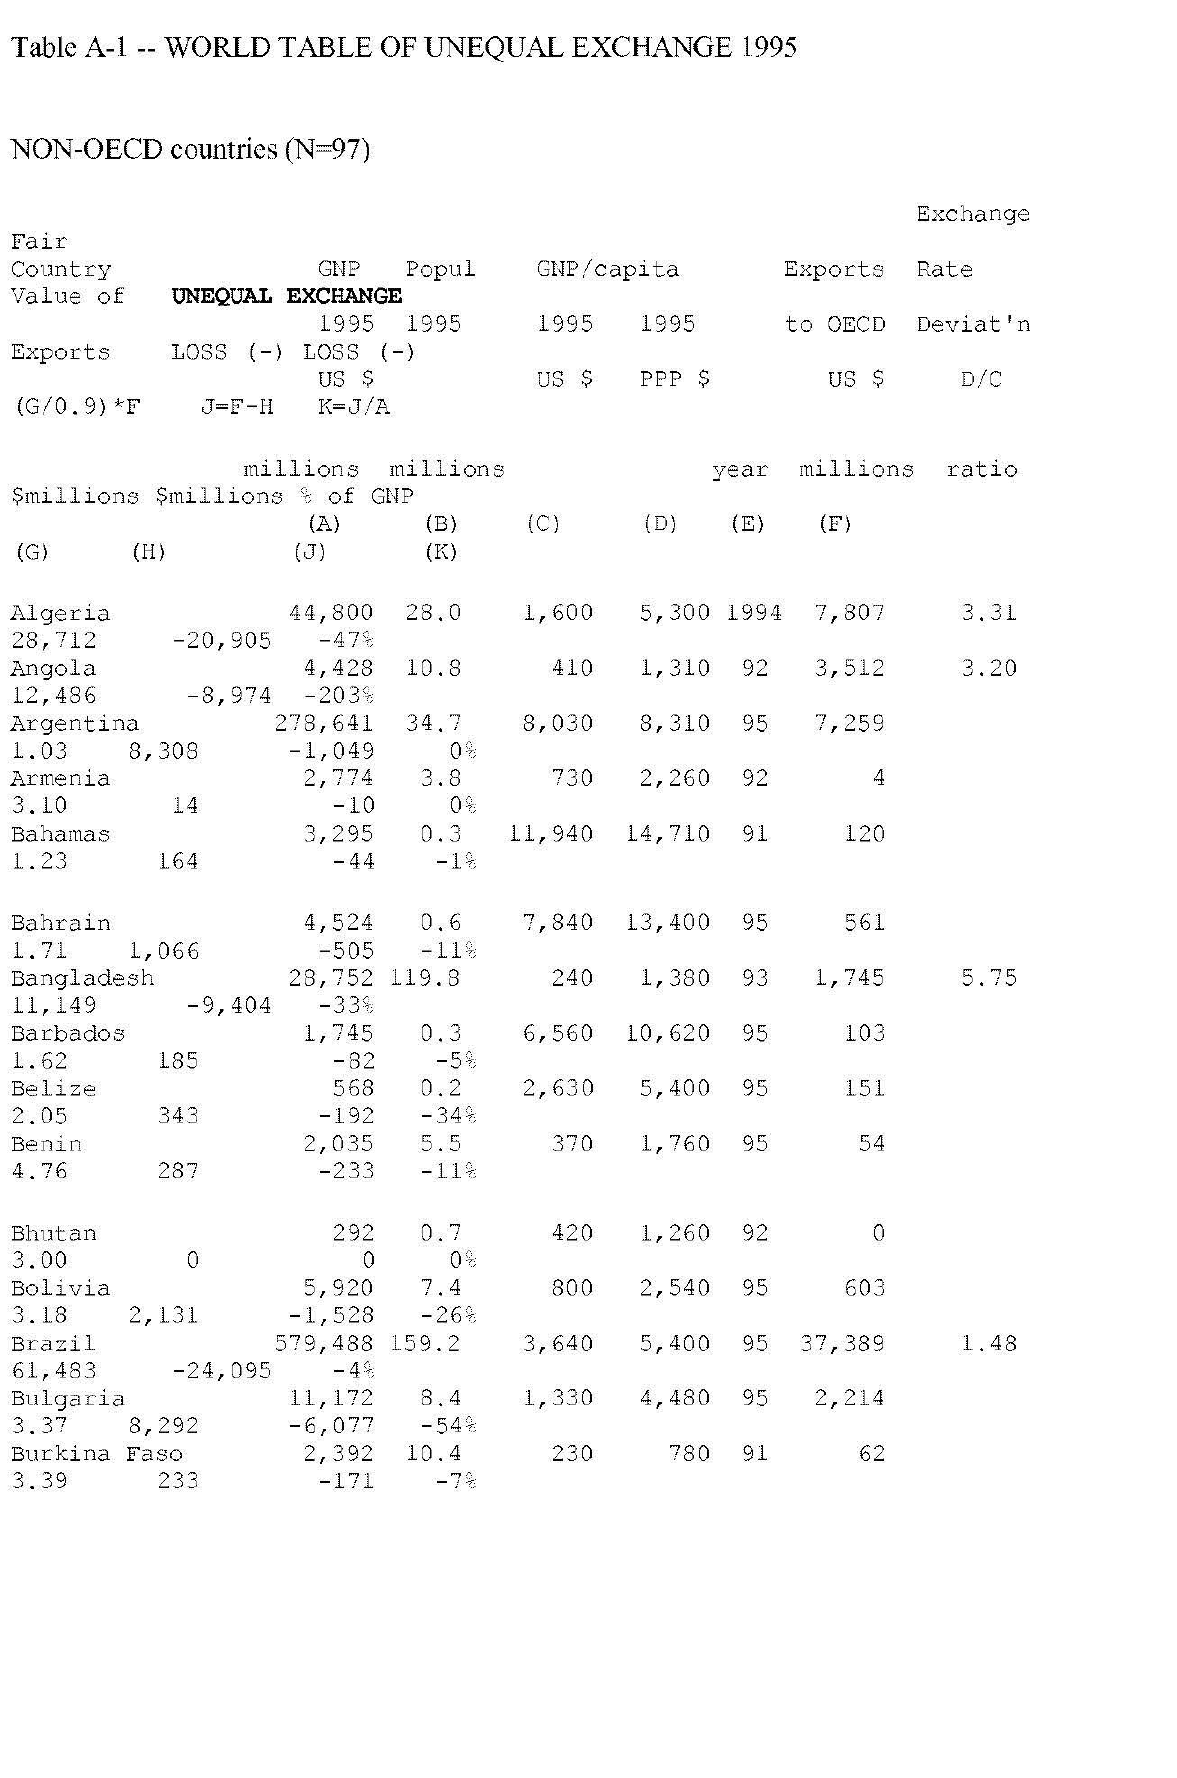
NON-O ECD countries